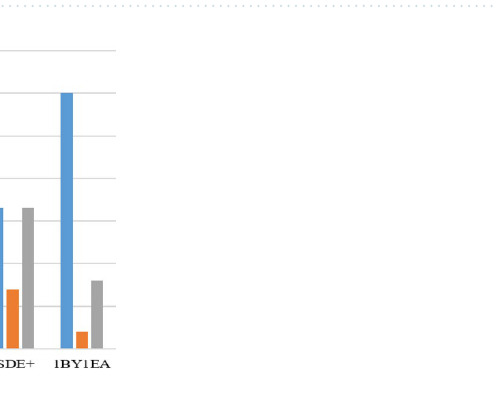
Table 2. Comparison of HV and statistical results on DTLZ and WFG test problems (“+”—win, “≈”—TIE, “−”—loss).